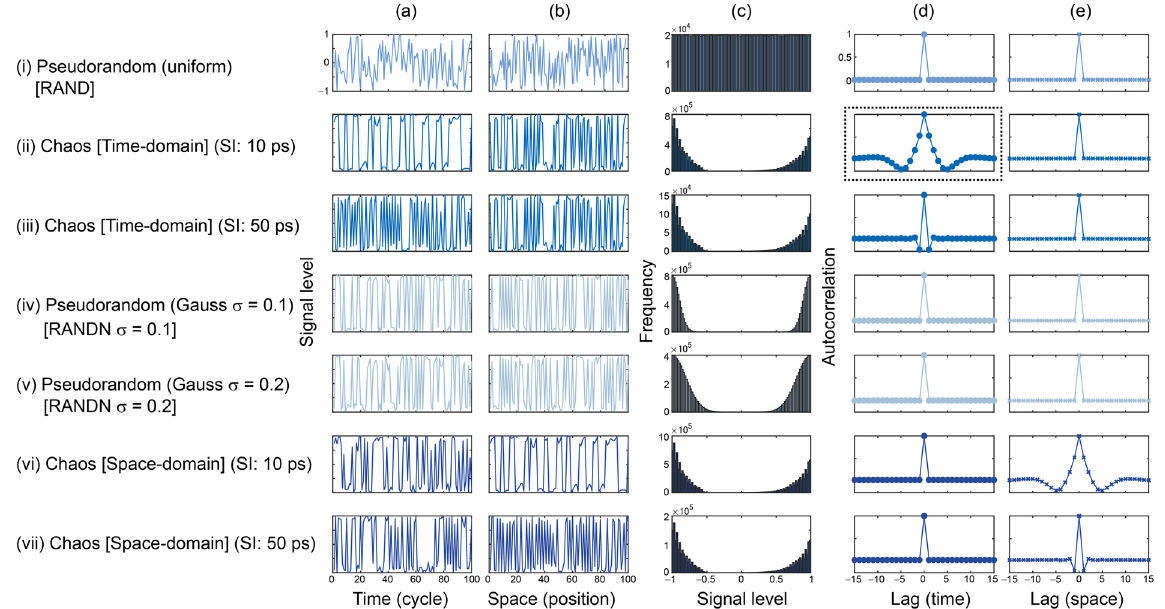
Figure 2. Random sequences for GAN. (i) Pseudorandom numbers. Chaos sequences arranged in the time domain with SI of (ii) 10 ps and (iii) 10 ps. Normally distributed pseudorandom numbers with standard deviations of (iv) 0.1 and (v) 0.2. Chaos sequences arranged in the space domain with SI of (vi) 10 ps and (vii) 50 ps. Signal-level profiles in ( a ) time and ( b ) space domains. ( c ) Signal level histogram. Autocorrelation in ( d ) time and ( e ) space